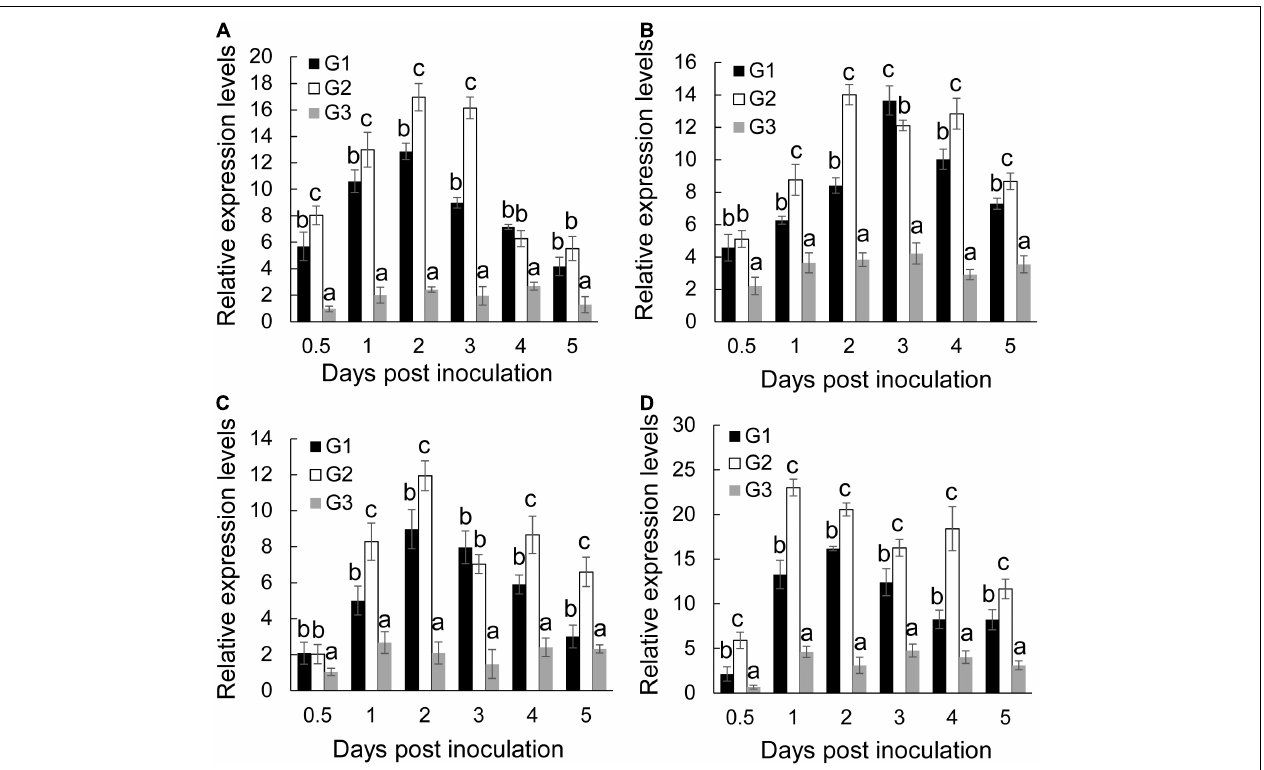
FIGURE 5 | Expression analysis of defense-related marker genes in banana roots. qRT-PCR determined the transcript levels of MaPR1 (A) , MaPAL (B) , Mab-1,3-Glu (C) , and MaMAPK1 (D) in banana roots after treatment with S. malaysiensis 8ZJF-21 at different time points. G1-G3 represented different treatment groups as described in Figure 4 . Error bars indicate standard errors of the means from three repeated experiments. Different letters indicate a significant difference according to Duncan’s multiple range test ( P <